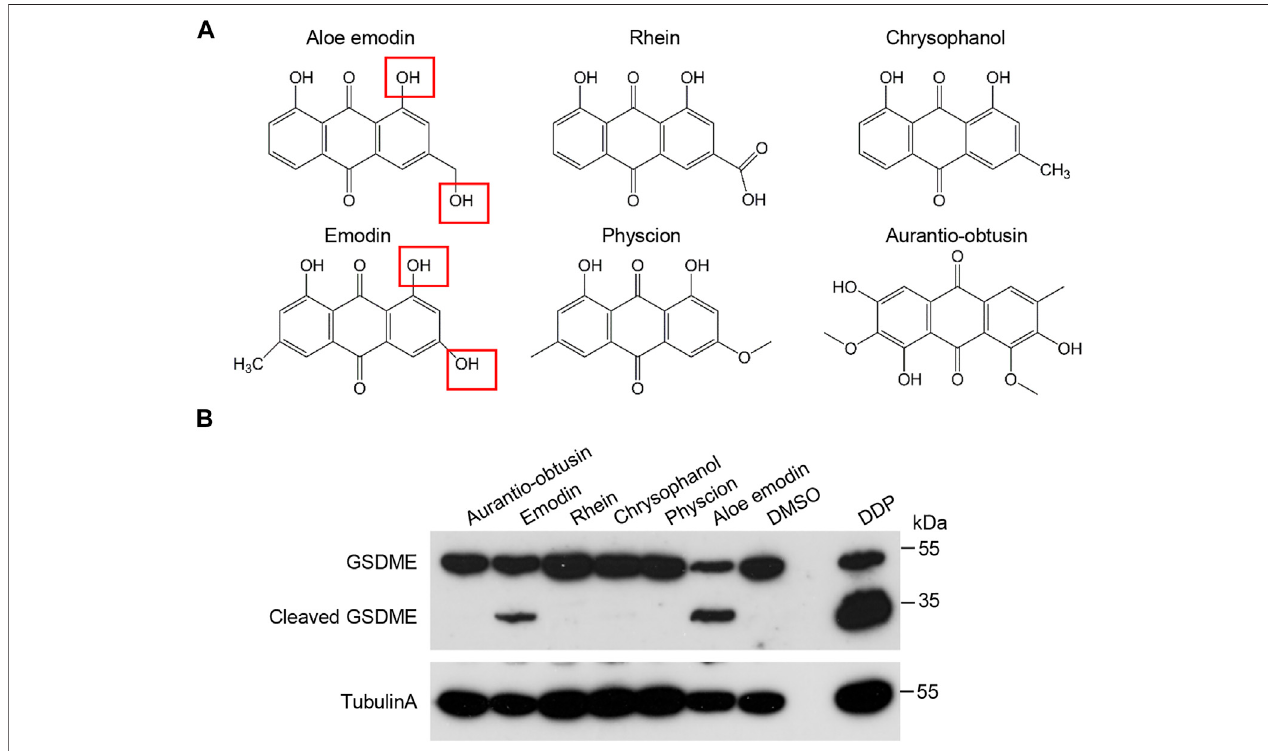
FIGURE 4 | Effects of the hydroxyanthraquinone derivations on GSDME activation. (A) The schematic structures of hydroxyanthraquinone derivations that are similartoAE. (B) Effectsofthehydroxyanthraquinonederivationsin (A) ontheGSDMEcleavage.HeLacellsweretreatedwith50 μ Mofchrysophanol,emodin,aurantio- obtusin, physcion, aloe-emodin, or rhein for 16 h, followed by immunoblotting analysis with the indicated antibodies. Data of immunoblots are representative of three independent